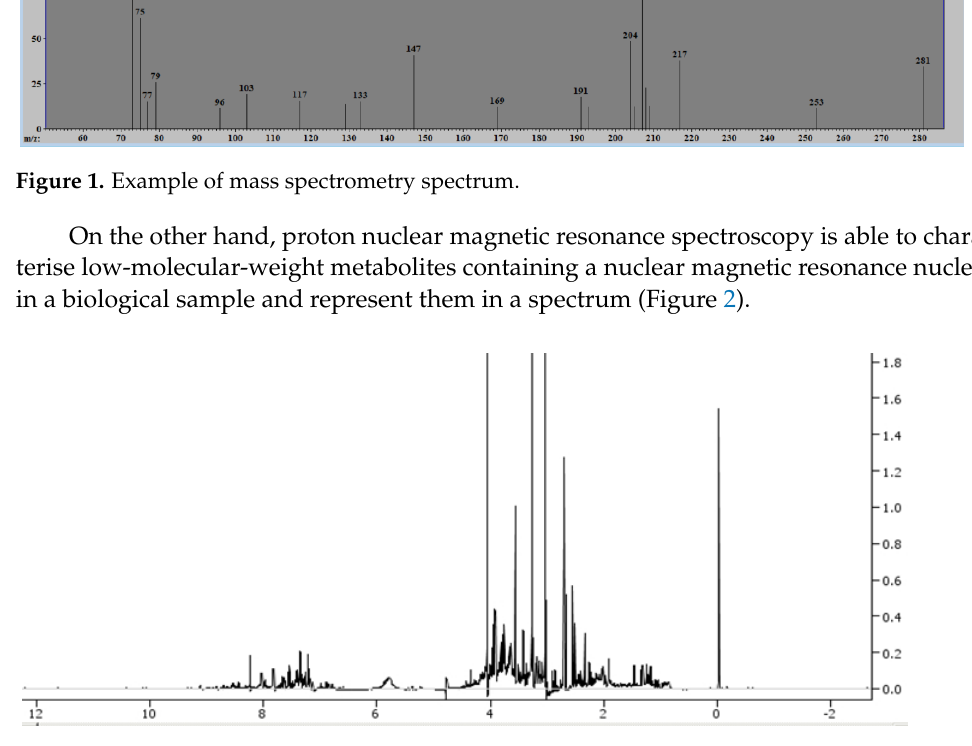
Figure 2. Example of nuclear magnetic resonance (NMR) spectrum.